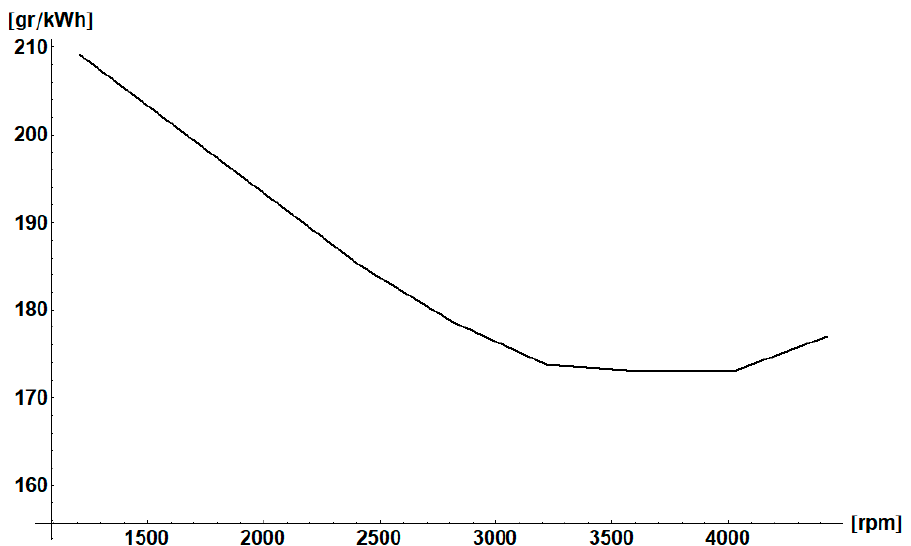
Figure 6. Brake Specific Fuel Consumption of a CR (Common Rail) Engine.